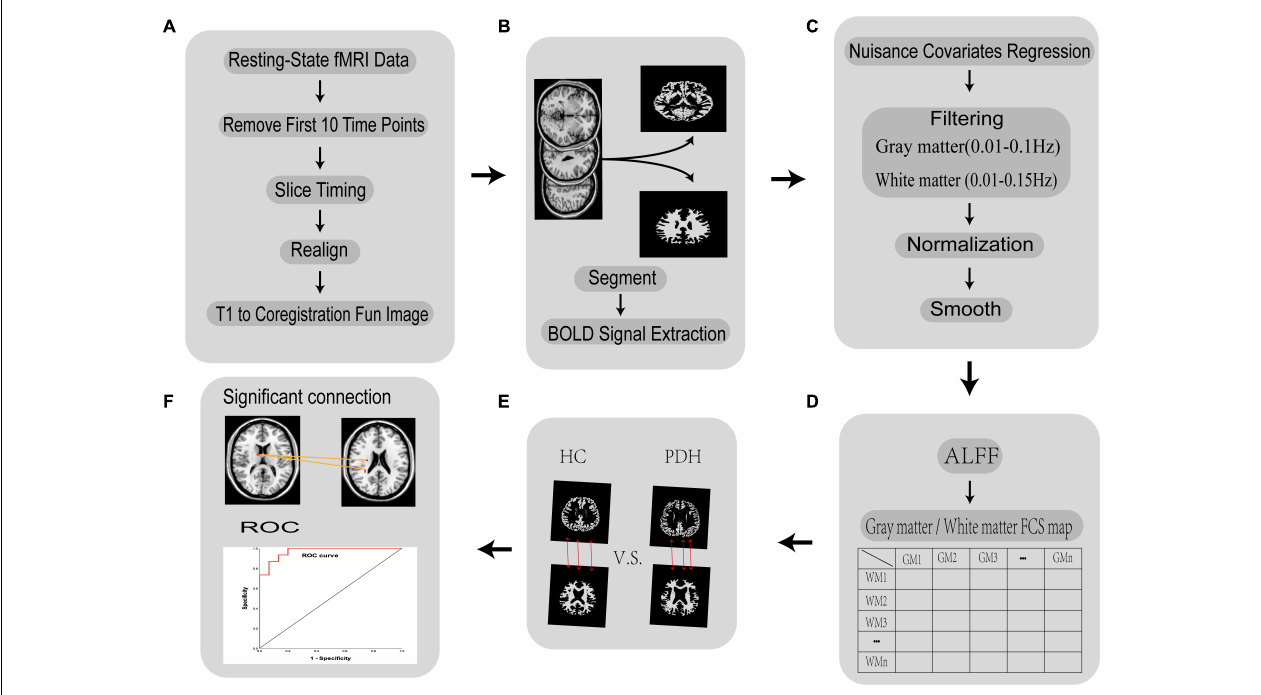
FIGURE 1 | Flow chart of the fMRI data processing in FCC analysis. (A) Removal of the first 10 time points, slice time correction, head movement correction, and individual image registration of functional images; (B) white matter-gray matter segmentation and BOLD signal extraction; (C) remove irrelevant noise, filter the BOLD signal of white matter and gray matter separately, normalize brain volumes to MNI space, smooth spatial brain volumes; (D) calculate ALFF and FCS; (E) conduct hypothesis testing and multiple comparisons for PDH and HC groups; (F) obtain meaningful brain areas and ROC